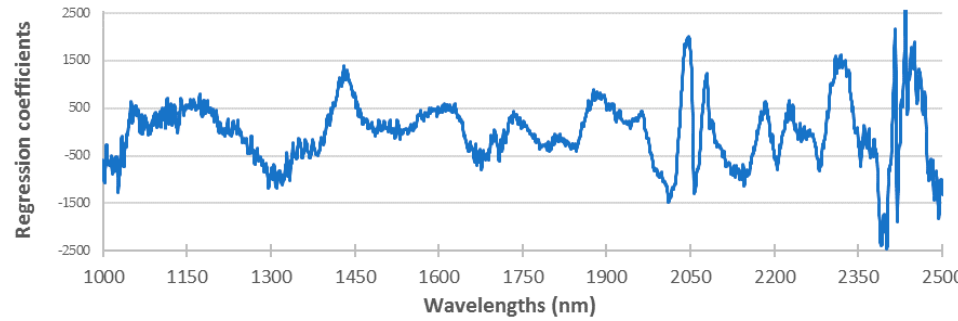
Figure 2. Regression coefficients of each wavelength for the model of total fatty acids.